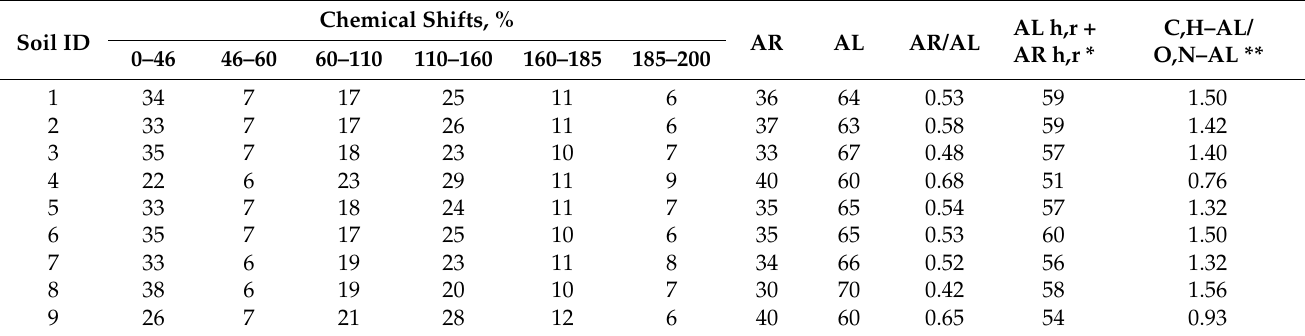
Figure 4. 13 C NMR spectra of study HAs separated from soils of the Lena River delta. The studied HAs accumulated mainly C,H-Alkyl ((CH 2 )n/CH/C and CH 3 ), aromatic compounds (C-C/C-H, C-O) and the OCH group (OCH/OCq) (Table 4). Table 4. Percentage of carbon in the main structural fragments of HAs from the studied soils.